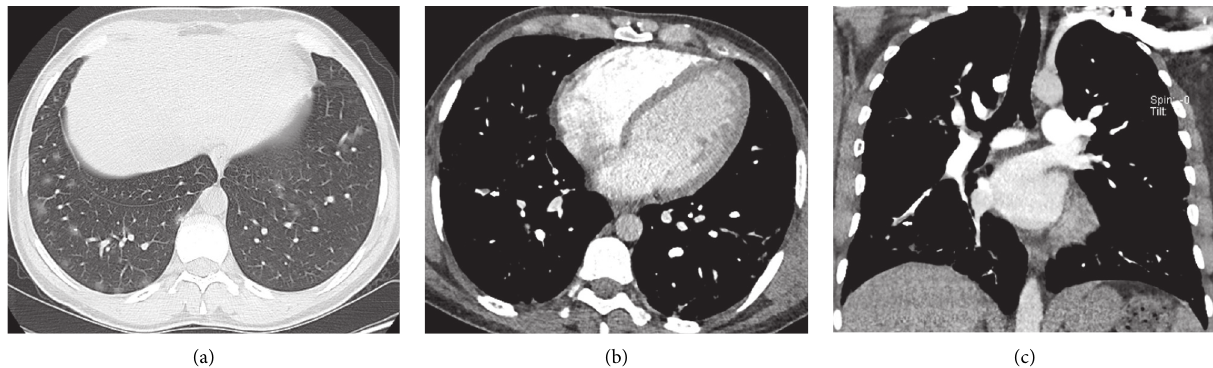
Figure 1: Images in a 38-year-old male with COVID-19 pneumonia complaining of fever and cough. (a) Axial unenhanced chest CTscan (lung window) obtained on day 5 after the onset of symptoms shows bilateral multiple patchy areas of ground-glass opacities more peripherally. (b) Axial CTpulmonary angiography scan. (c) Coronal reformatted images (mediastinum window) on day 19 after the onset of symptoms demonstrate filling defects (white arrow) within the segmental pulmonary artery branch supplying the lateral basal segment of the right lower lobe.